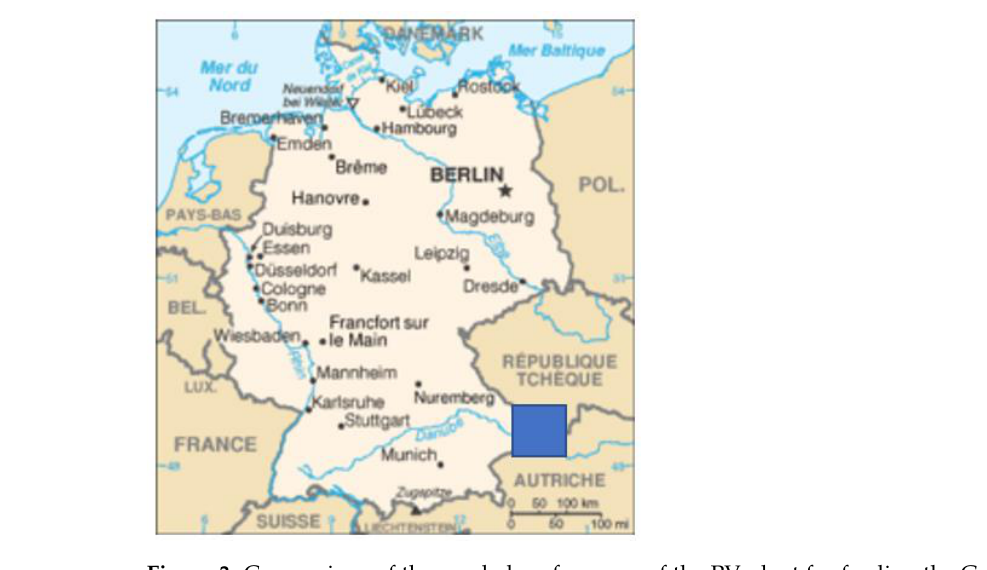
Figure 3. Comparison of the needed surface area of the PV plant for feeding the German car fleet to e-methanol.